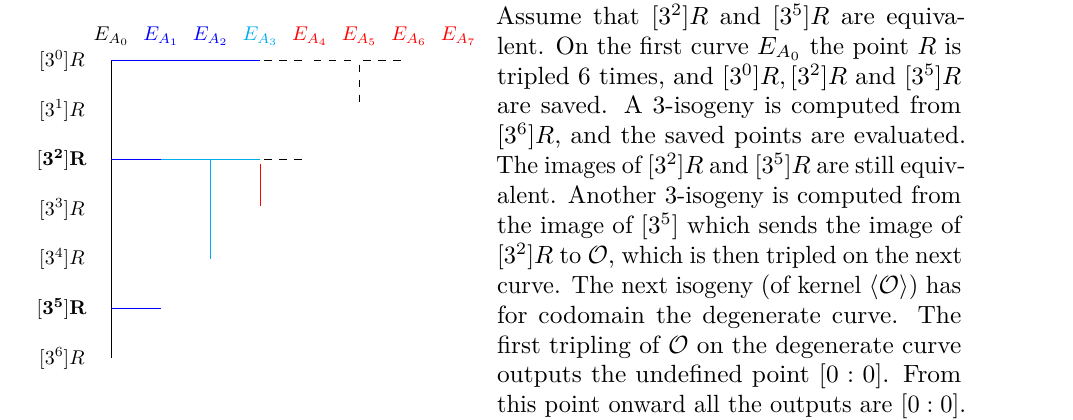
Figure 1: An example of a 3 7 -isogeny computation with a kernel of wrong order